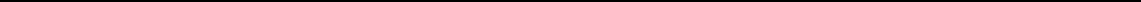
Fig. 2 SKP2 interacts with YAP and induces its K63-linked polyubiquitination. a The HEK293T SFB-YAP stable cell line was transfected with MYC-tagged E3 ligases, followed by immunoprecipitation with anti-MYC beads and immunoblotting with antibodies against FLAG and MYC. b The HEK293T SFB-YAP stable cell line was co-transfected with the K63-speci fi c mutant of HA-ubiquitin and the indicated E3 ligase, followed by pulldown with S-protein beads and immunoblotting with antibodies against HA and FLAG. c Co-immunoprecipitation of endogenous SKP2 with endogenous YAP. d In vitro binding of bacterially puri fi ed MBP-SKP2 to in vitro translated and puri fi ed GST-YAP. e In vitro binding of bacterially puri fi ed MBP-SKP2 to SFB-YAP puri fi ed from the HEK293T SFB-YAP stable cell line. MBP-SKP2 or MBP protein was incubated with SFB-YAP protein with or without CIP treatment at 37 °C for 1 h, followed by immunoblotting with antibodies against SKP2, p-YAP (S127), and FLAG. f The HEK293T SFB-YAP stable cell line was transfected with HA-ubiquitin (wild-type, K48R or K63R) and MYC-SKP2, followed by pulldown with S-protein beads and immunoblotting with antibodies against HA and FLAG. g The HEK293T SFB-YAP stable cell line was transfected with HA-ubiquitin (wild-type, K48-speci fi c or K63-speci fi c) and MYC-SKP2, followed by pulldown with S-protein beads and immunoblotting with antibodies against HA and FLAG. h Total K63-linkage speci fi c ubiquitinated proteins in control or SKP2 knockout HEK293A cells (generated by CRISPR-Cas9) were immunoprecipitated by a K63-linked polyubiquitin-speci fi c antibody, followed by immunoblotting with antibodies against YAP and ubiquitin. i siRNA targeting CUL1 or SKP1 was transfected into the HEK293T SFB-YAP stable cell line. Forty-eight hours after siRNA transfection, cells were transfected with HA-ubiquitin and MYC-SKP2, followed by pulldown with S-protein beads and immunoblotting with antibodies against HA and FLAG. j The HEK293T UBCH5c shRNA stable cell line was transfected with SFB-YAP and HA-ubiquitin with or without MYC- SKP2, followed by pulldown with S-protein beads and immunoblotting with antibodies against HA and FLAG. k Puri fi ed GST-YAP protein was incubated with ATP, E1, UBCH5c, and the K63-speci fi c mutant of His-ubiquitin with or without the SCF SKP2 complex, followed by immunoprecipitation with a YAP- speci fi c antibody and immunoblotting with antibodies against ubiquitin and